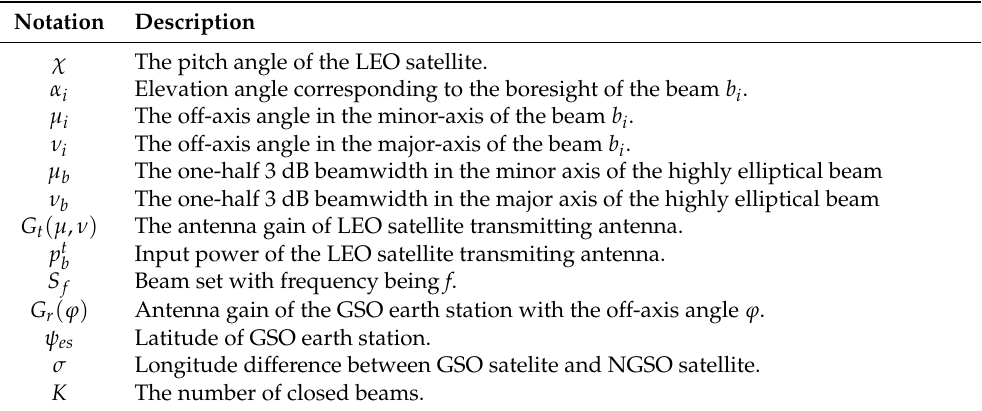
Table 1. Notations used in this paper.